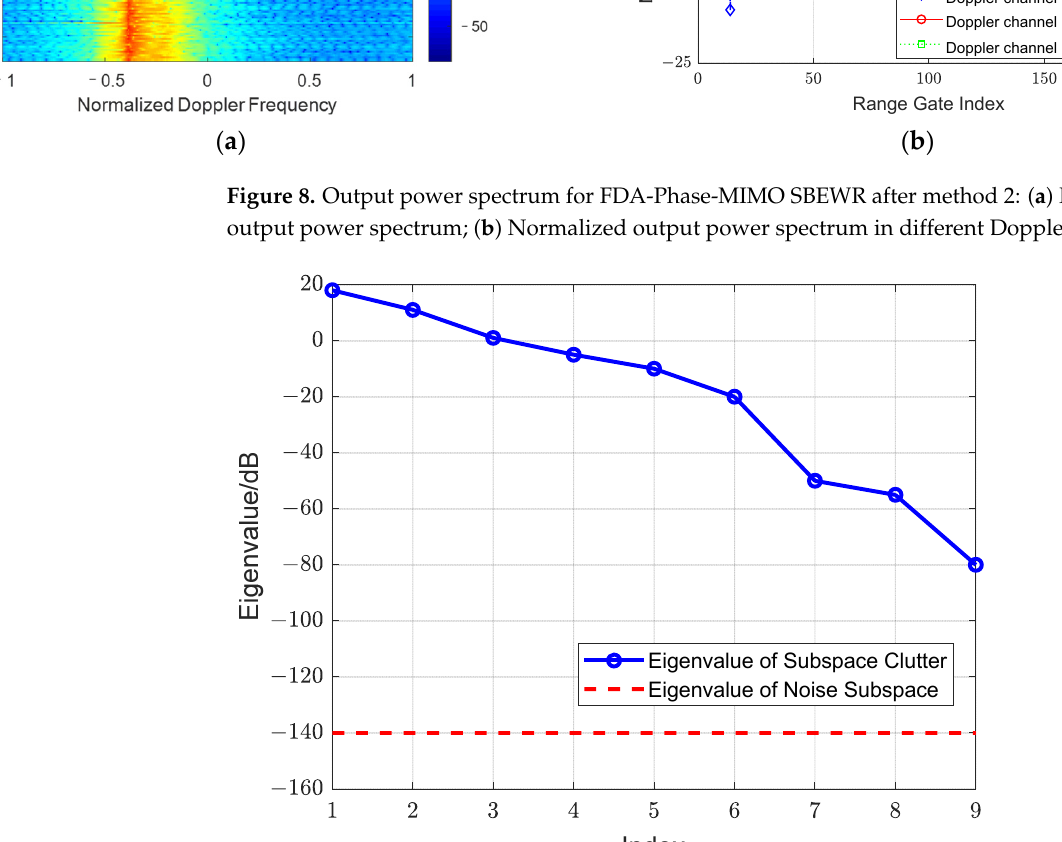
Figure 9. The eigenvalue spectrum of reduced dimensional clutter covariance matrix. Through the 3D dimensionality reduction joint adaptive processing method (method 3, Figure 3((1.b)–(3.b)), the radar system could achieve great clutter suppression perfor- mance when the auxiliary channel has been selected reasonably. In this section, the per- formance obtainable by all dimensionality reduction methods is analyzed and compared . Figures 10a and 11a show the R-D output power spectrum obtained by method 3.a and method 3.b, respectively, and Figures 10b and 11b show the eigenvalue spectrum of the CCM when the target unit is approaching the main clutter. Compared with the past cascaded method, 3D joint adaptive processing has better range ambiguous clutter sup- pression performance. From the eigenvalue spectrum of the two CCM, it can be found that by using method 3.a, the CCM has more small eigenvalues, i.e., extra available DOFs for adaptive processing, compared to method 3b, which obtains a covariance matrix that does not satisfy the criterion that the DOFs of the system are greater than the DOFs of the clutter.